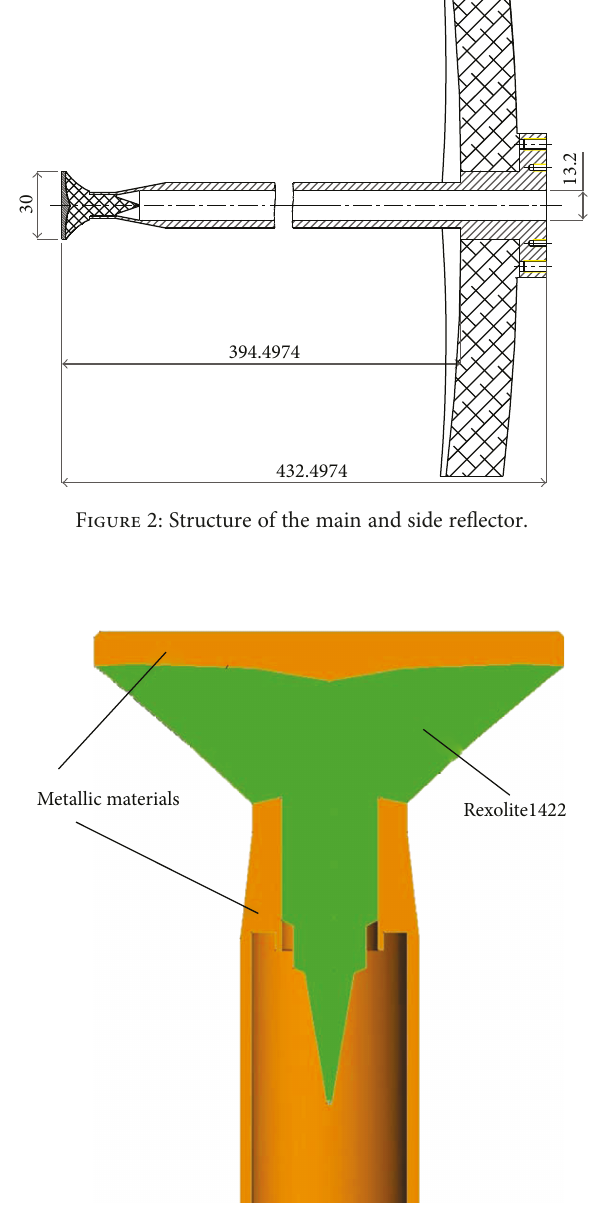
Figure 3: Exploded view of the feed structure.